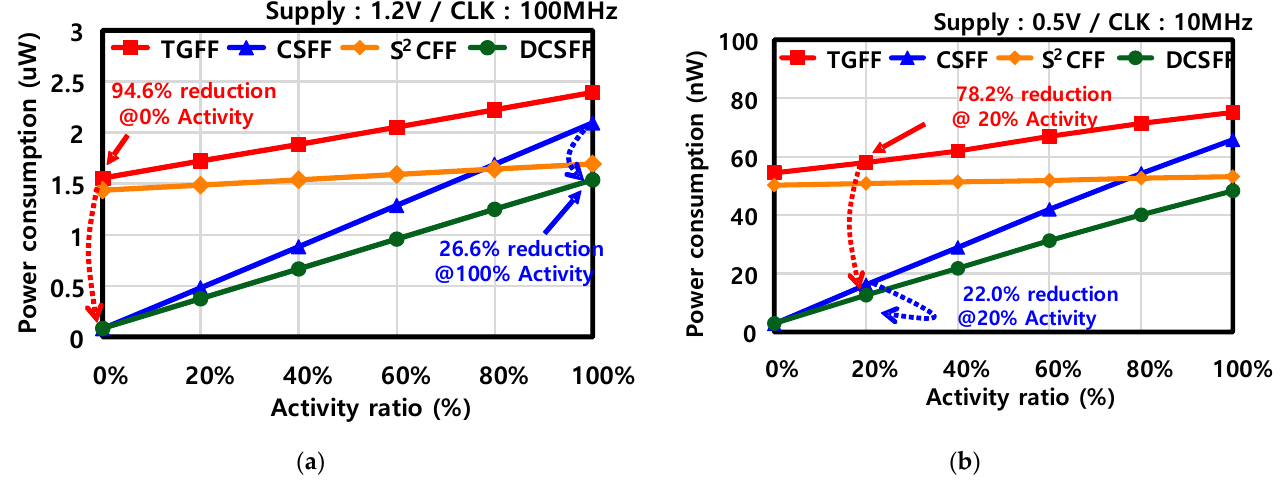
Figure 13. Measured Power Consumption. ( a ) 1.2 V Supply and 100 MHz Clock ( b ) 0.5 V Supply and 10 MHz Clock.